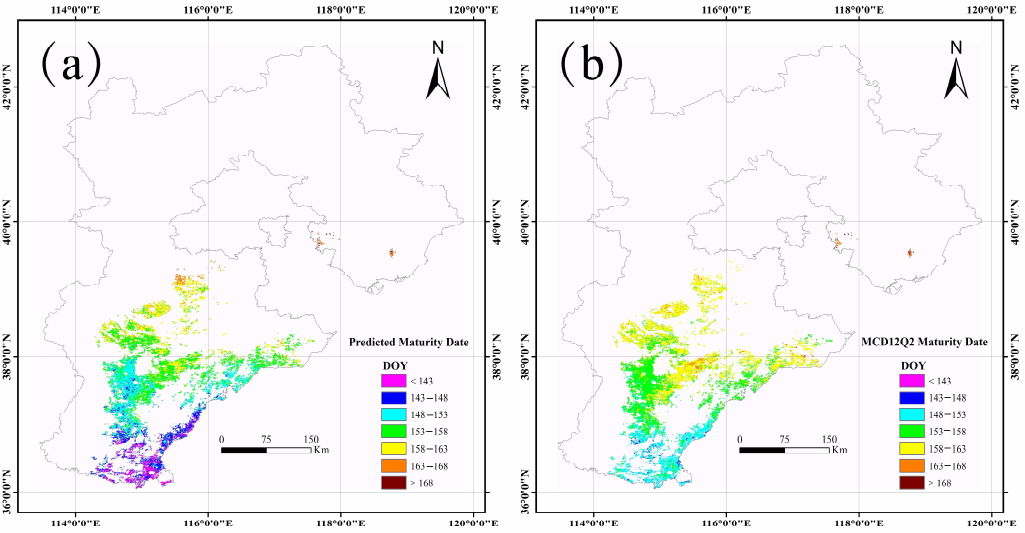
Figure 5. Spatial distribution of winter wheat MD by ( a ) prediction and ( b ) MCD12Q2 product.